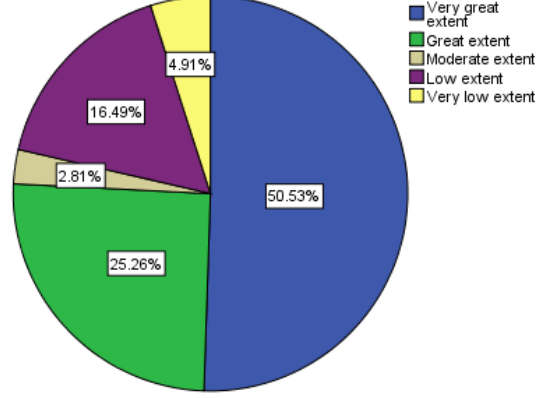
Figure 3. Pie chart showing the responses on co-worker